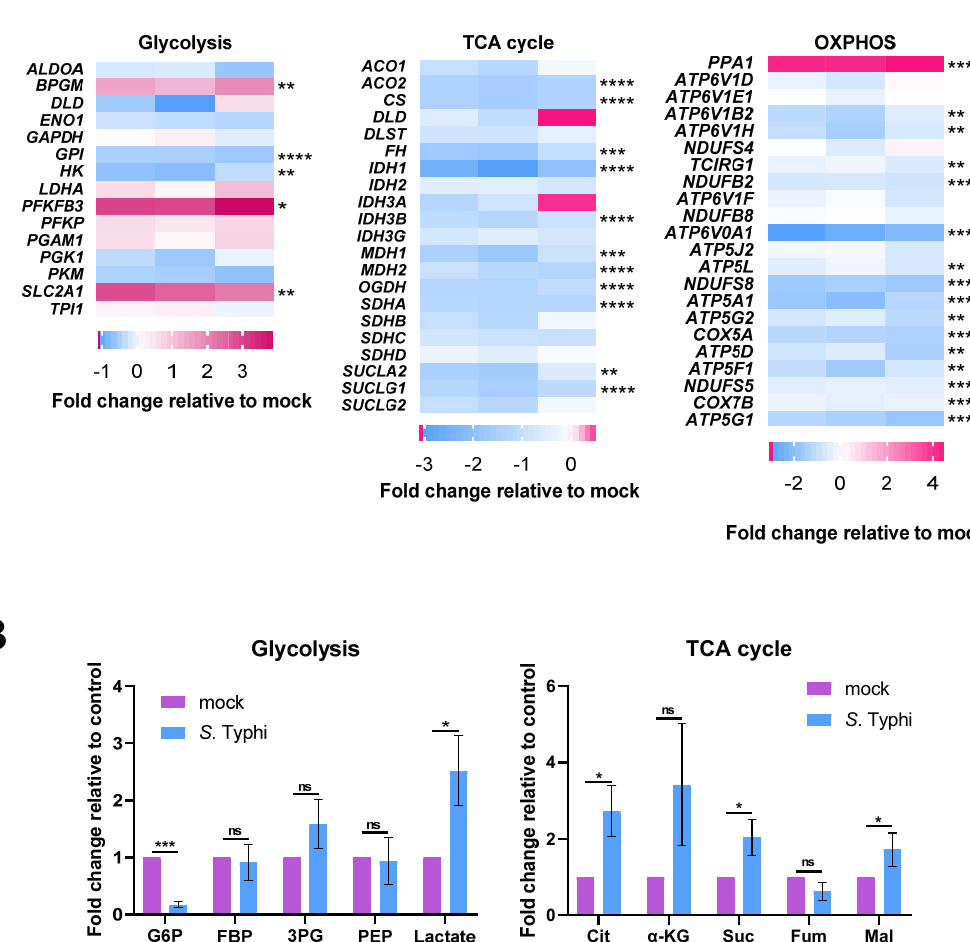
Figure 2. Transcriptomes and metabolomics analysis show Salmonella enterica serovar Typhi ( S. Typhi) infection increases glycolysis while suppressing the tricarboxylic acid (TCA) cycle and oxidative phosphorylation (OXPHOS) in human macrophages. ( A ), Heat map of the gene expression of glycolytic metabolism (left), the TCA cycle (middle), and OXPHOS (right) in S . Typhi-infected MDMs vs. mock-infected MDMs. Fold changes of the relative gene expression levels are displayed in the heat maps, with pink representing higher and blue representing lower abundance. ( B ) Fold change in metabolites of glycolysis (left) or the TCA cycle (right) in S . Typhi-infected MDMs vs. mock-infected MDMs. Glucose 6-phosphate (G6P), fructose-1,6-diphosphate (FBP), 3-phosphoglycerate (3PG), phosphoenolpyruvate (PEP), citrate (Cit), α -ketoglutarate ( α -KG), succinate (Suc), fumarate (Fum), malate (Mal). ( A , B ) Data were obtained from three independent experiments and analyzed using one-way ANOVA. * p < 0.05; ** p < 0.01; *** p < 0.001; **** p < 0.0001; ns, not significant.